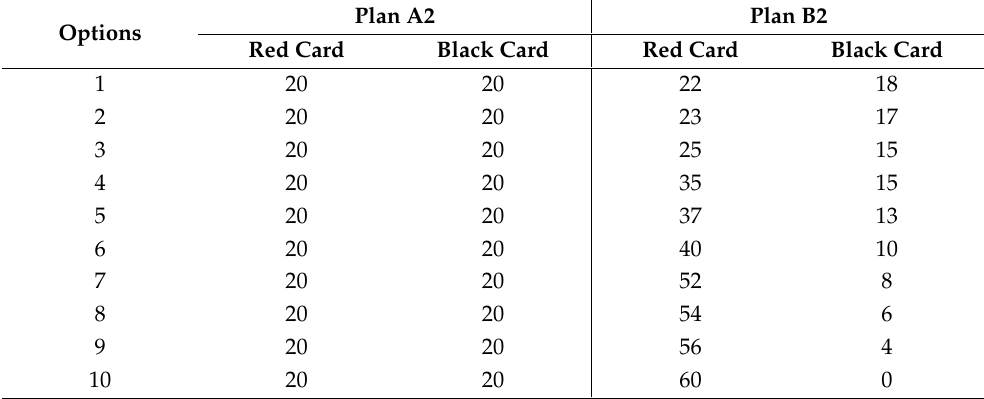
Table 4. Experimental